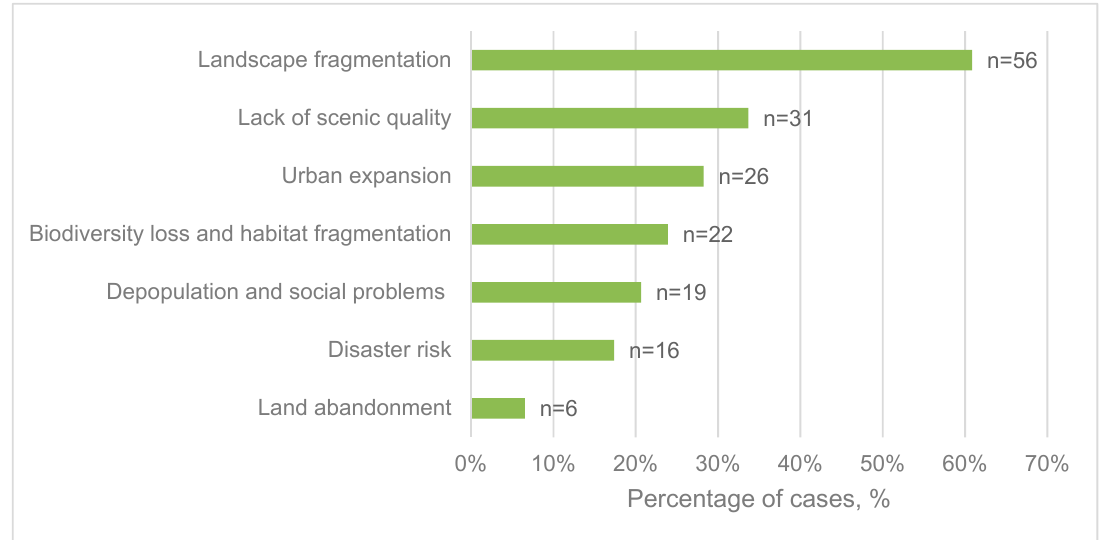
Figure 5. Problems and issues addressed by landscape corridors (n = 92).